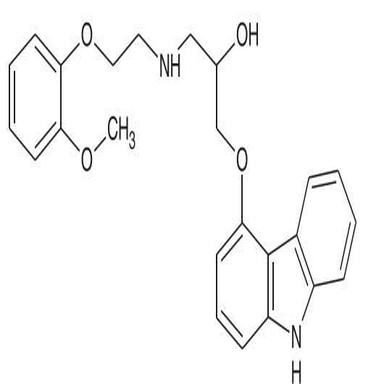
Chemical structure of carvedilol – 1-(9H-carbazol-4-yloxy)− 3-− 2-propanol.